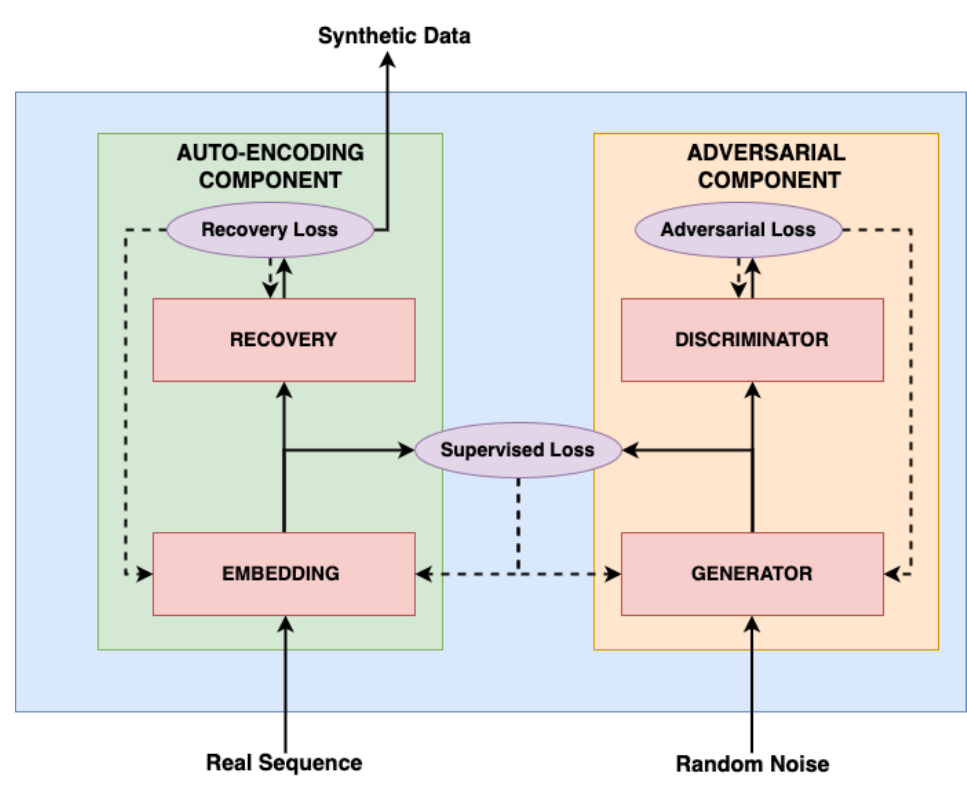
Figure 4. Components of MTS-TGAN